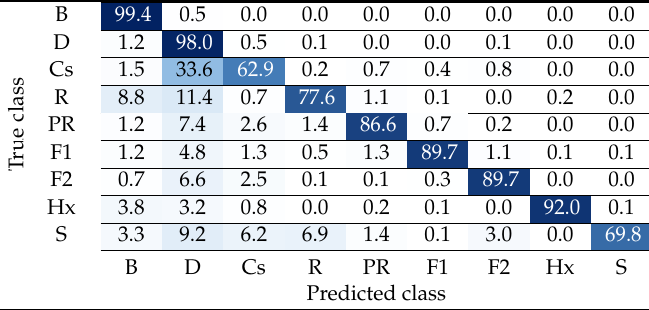
Table 2. Averaged and normalized confusion matrix.